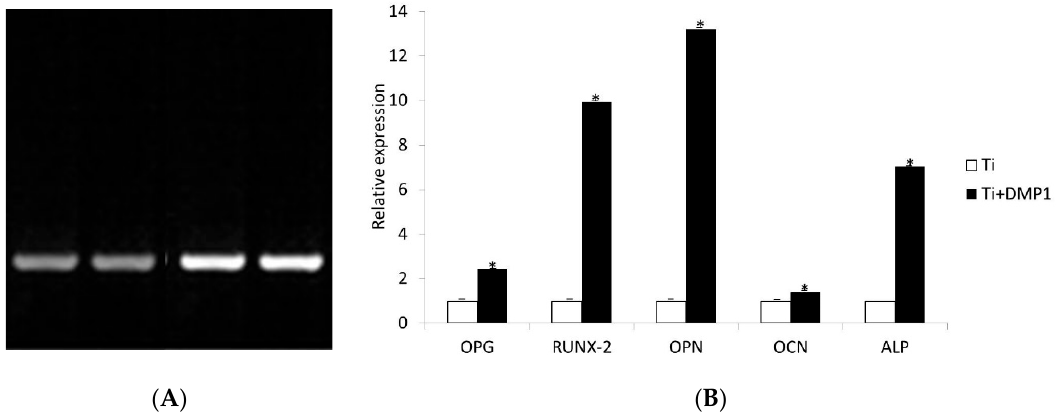
Figure 6. ( A ) Cdna gel of HMSCs for 2 experimental groups (C and NC) (A, B: Non-coated titanium surface and C, D: DMP1 coated titanium surface). ( B ) Quantitative comparison of RT-PCR of OPG, RUNX2, OPN, OCN, and ALP mRNA from hMSCs cultured on DMP1 coated or uncoated disks. All values were normalized to GAPDH mRNA levels. Experiments were performed in triplicate. RT-PCR = Real-time polymerase chain reaction, RUNX2 = runt-related transcription factor 2, OPG = osteoproteg e rin, OCN = osteocalcin, OPN = osteopontin, ALP = alkaline phosphatase.